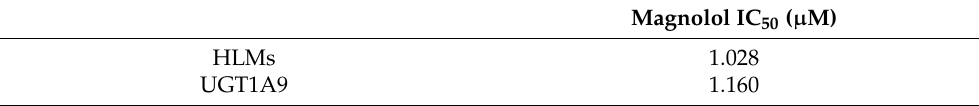
Table 5. Inhibition of PTU glucuronidation in HLMs and recombinant UGT1A9 by magnolol.